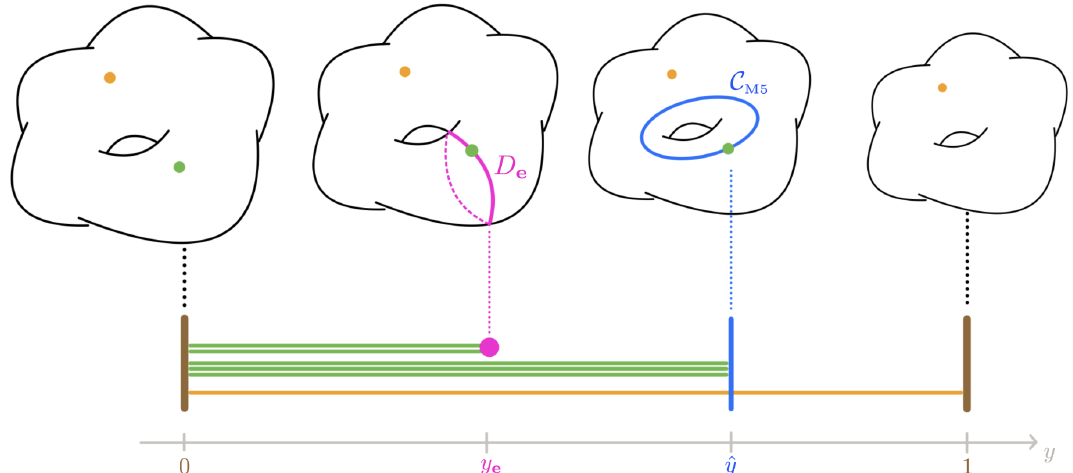
Figure 2 . EFT strings in E 8 × E 8 heterotic models . The bulk sector is as in figure 1, but now the picture includes two EFT strings: an orange M2-brane stretching between the HW walls, which descends to the critical heterotic string in ten dimensions; a bound state of ( p a − m a ) e a = 2 green open M2-branes and a purple M5-brane wrapping the nef divisor D e ⊂ X and sitting at y = y e . There also appear m a e a = C · D e = 3 green open M2-branes, connecting the left HW wall with